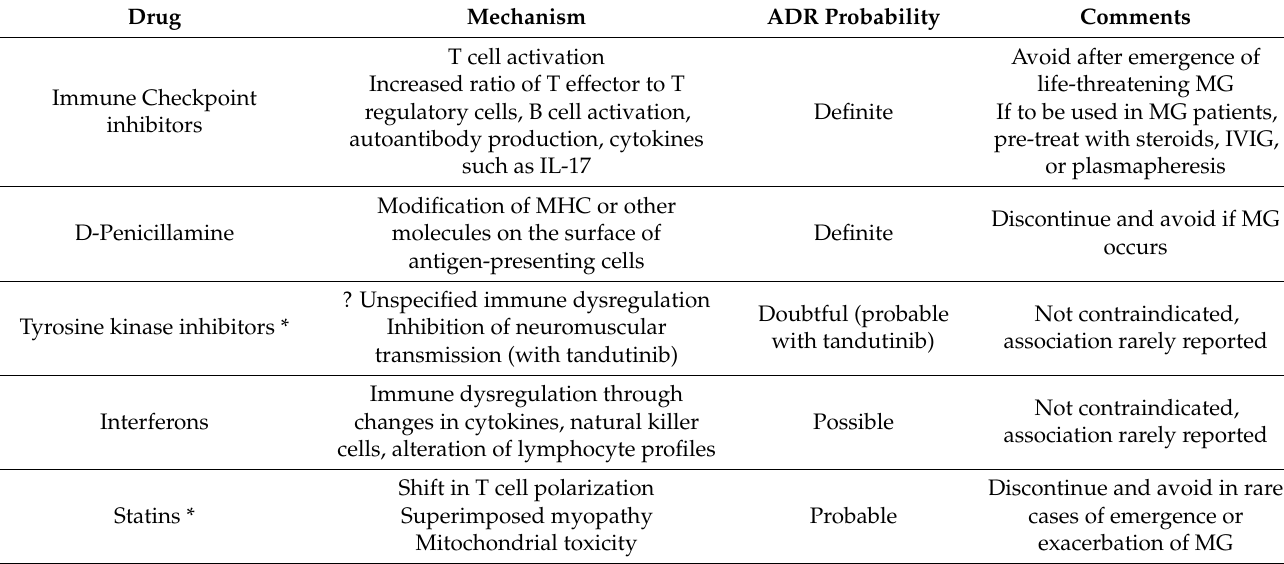
Table 1. Drugs reported to cause de novo MG or MG exacerbation through altering the immune response.